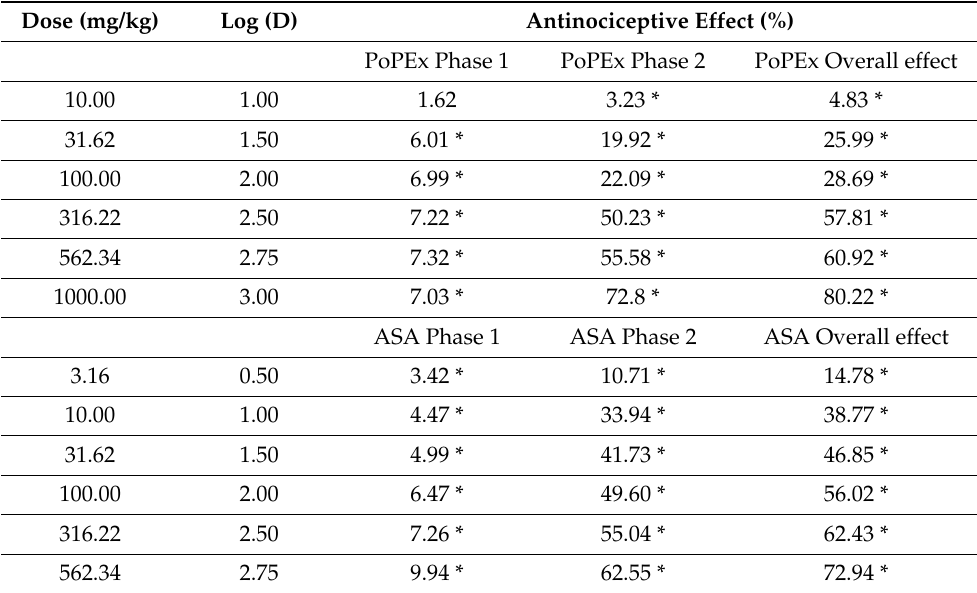
Table 1. Phased and overall antinociceptive effect (%) of PoPEx and ASA in the formalin test. Dose (mg/kg)